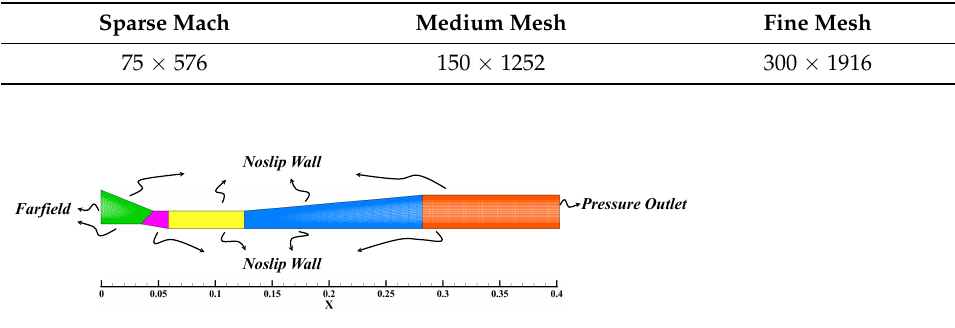
Figure 4. Mesh of the 2D computational